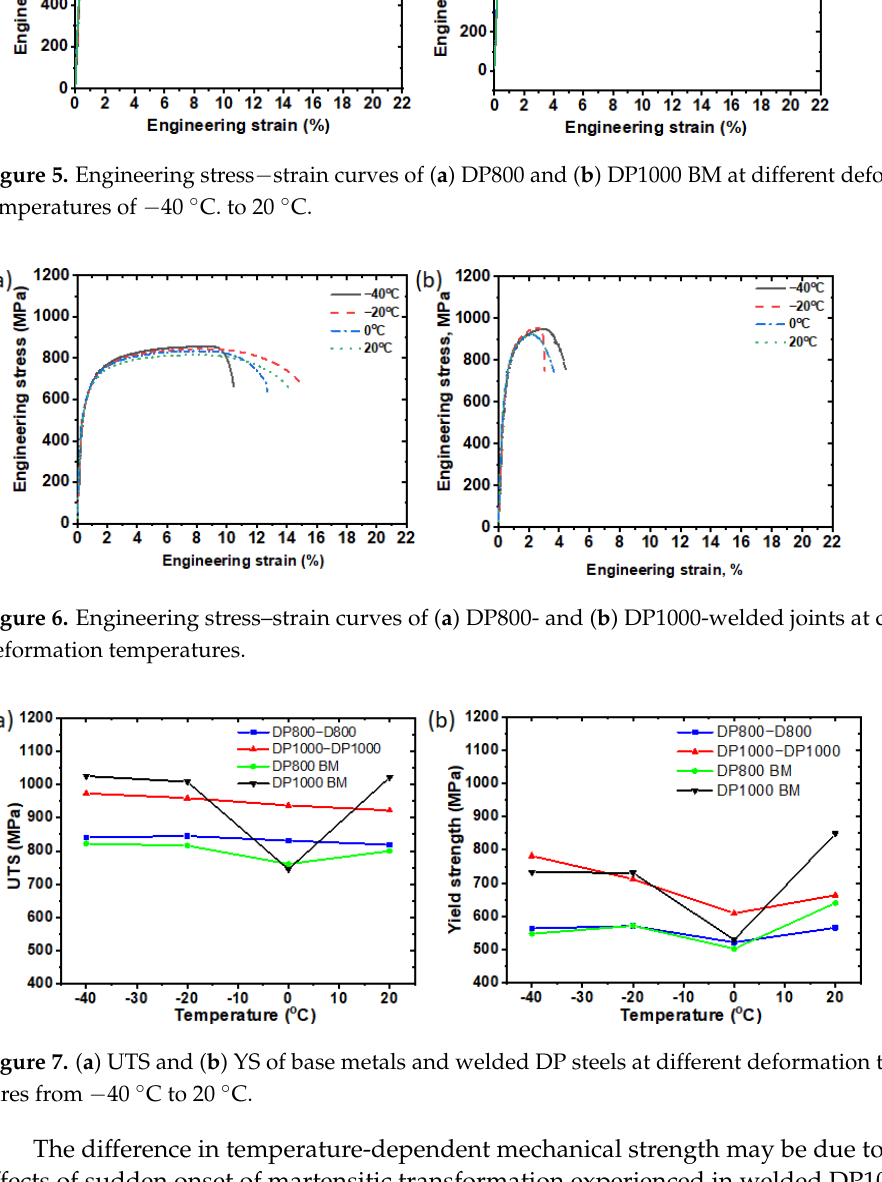
Figure 8. Representative fracture samples of DP800-DP800 ( a – d ) and DP1000 − DP1000 ( e – h ) between testing temperatures of − 40 °C and 20 °C.